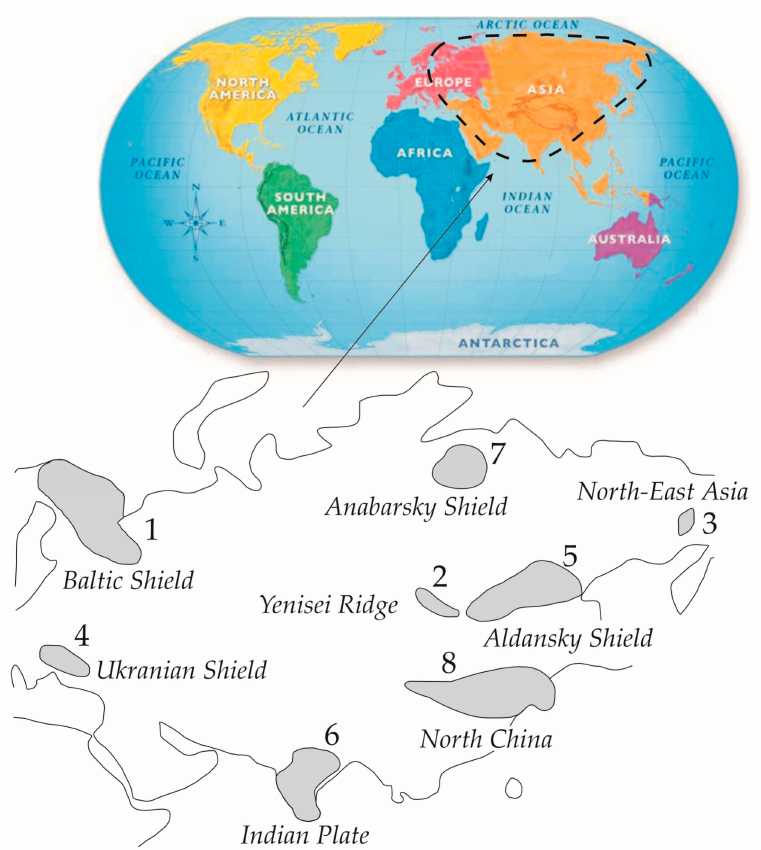
Figure 2. Scheme of the location of the Precambrian structures in Eurasia with the studied ancient collision